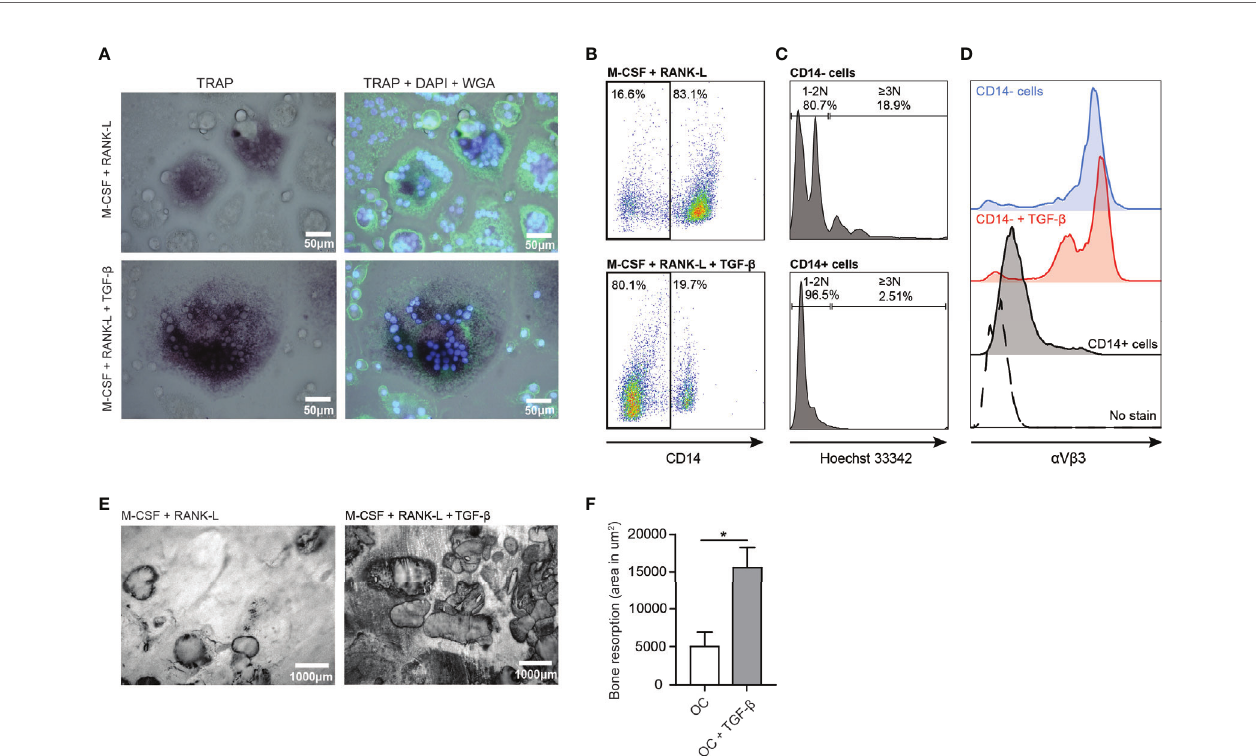
FIGURE 3 | Enhanced osteoclast formation and activity in presence of TGF- b . (A) Osteoclast TRAcP expression (purple) in presence of M-CSF and RANK-L (upper left panel) and in presence of M-CSF, RANK-L and TGF- b (lower left panel) after 7 days culture. [Blue (DAPI) = nuclei, green (WGA) = cell membrane]. (B) CD14 expression on osteoclasts in absence (upper panel) or presence of TGF- b (lower panel) after 7 days culture. (C) Number of nuclei present in CD14- (upper panel) and CD14+ (lower panel) cells after 7 days of culture in presence of M-CSF and RANK-L. (D) Expression of a V b 3 on formed osteoclasts in absence (blue (top) histogram) or presence of TGF- b (red (second) histogram) after 7 days culture. Residing CD14 + cells (black histogram) and non-stained cells (dotted histogram) served as controls. (E) Bone resorption by human osteoclasts after 21 days in presence of M-CSF and RANK-L (left panel) or M-CSF, RANK-L and TGF- b (right panel) (representative of n =2 experiments). (F) Quanti fi cation of bone resorption by osteoclasts in absence of TGF- b (white bar) or presence of TGF- b (grey bar) presented as area in m m 2 bone resorption. Data was analyzed using unpaired student ’ s two-tailed T test; * p ≤